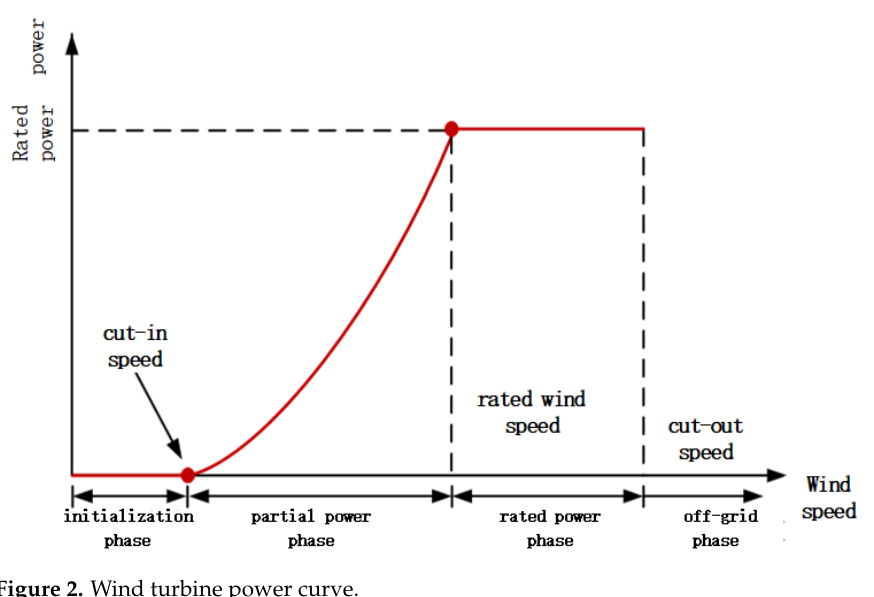
Figure 2. Wind turbine power curve.